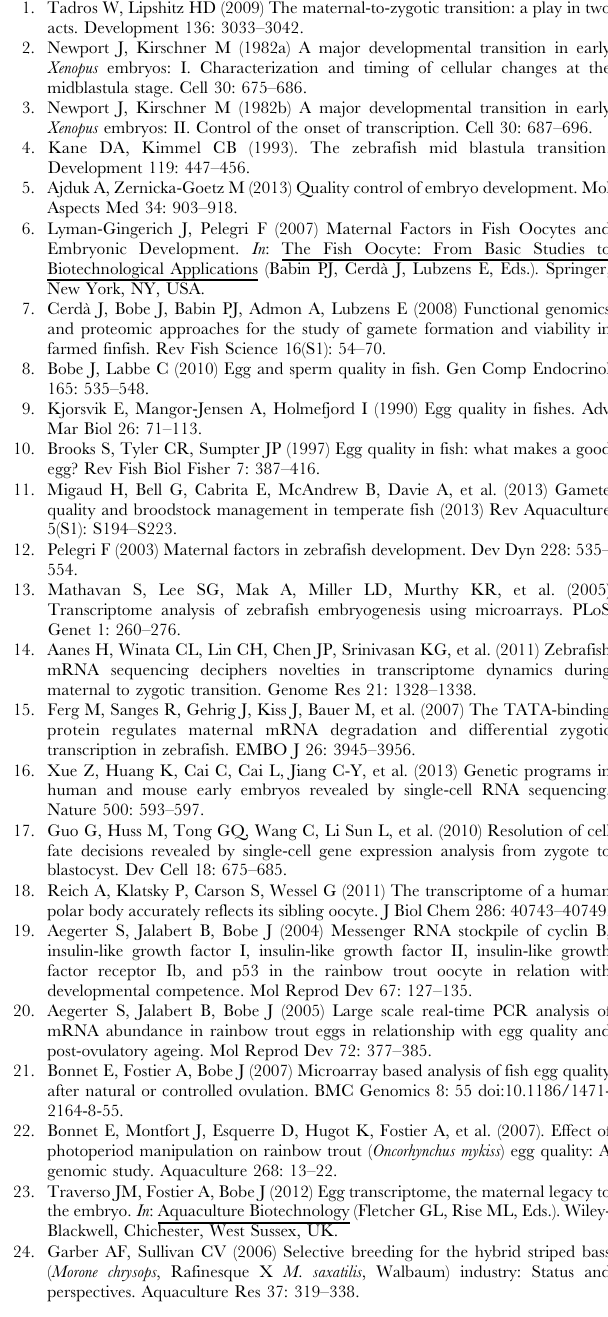
Table S1 Microsatellite loci used for genotyping and National Center for Biotechnology Information (NCBI) accession informa- tion. Table S2 Differential of expression of genes (n =233) in the ovaries of females producing low versus high egg quality